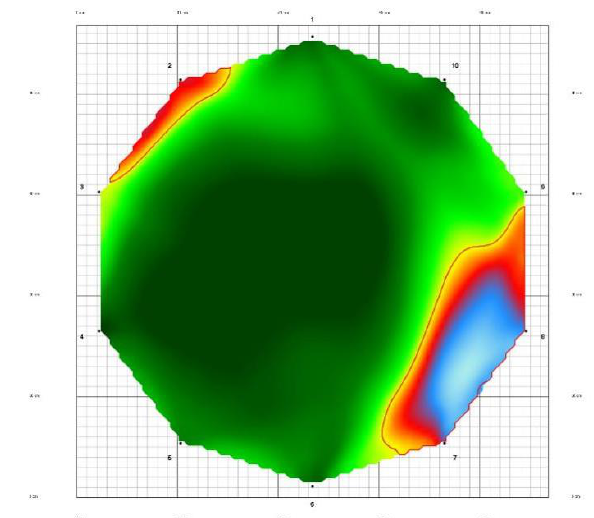
Figure 11 Stress wave pseudo image of D5 pillar of